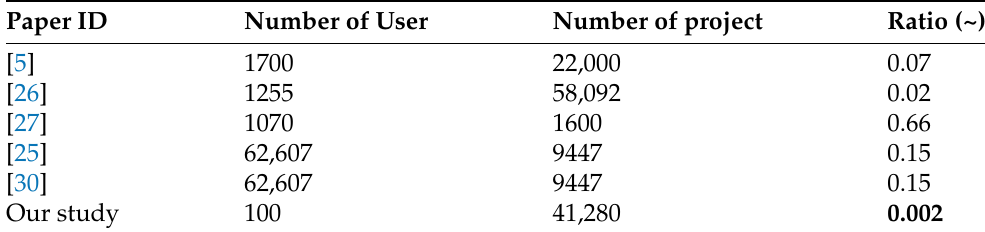
Table 2. The dataset sparsity of related studies.